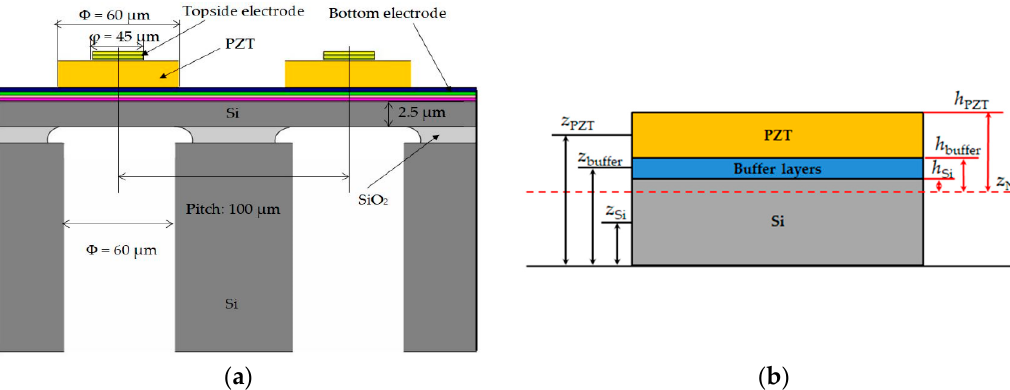
Figure 1. ( a ) Schematic illustration of the piezoelectric micromachined ultrasound transducer (pMUT) linear array with partially-etched lead zirconate titanate (PZT) thin film; ( b ) Simplified structure to calculate flexural rigidity.